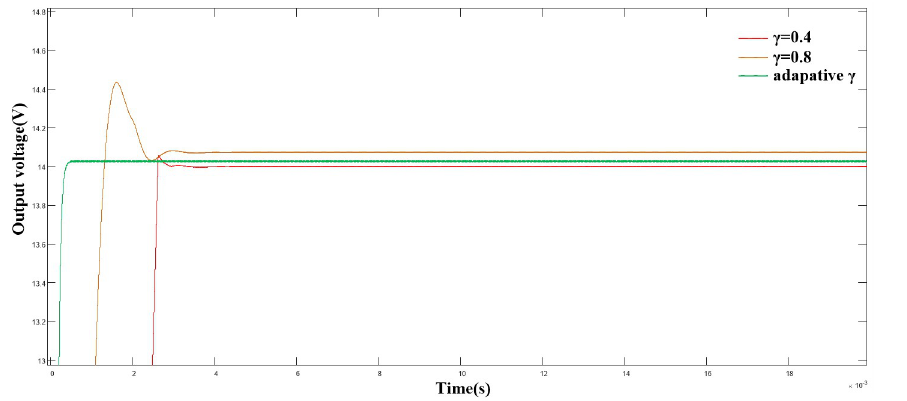
Fig 9. Comparison of output voltage with adaptive algorithm.